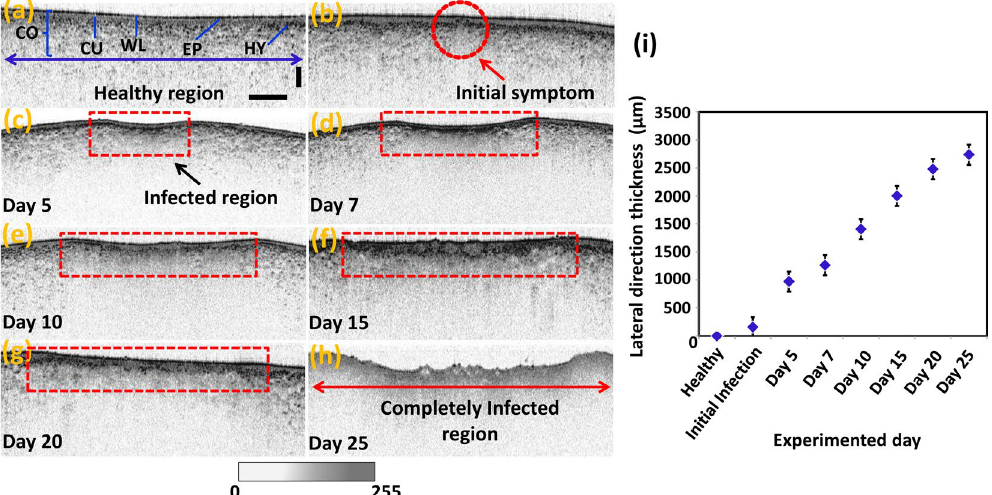
Figure 4. Morphological changes as a function of the incubation of bitter rot disease ( a–h ). Graph ( i ) depicts the gradual thickness expansion of the infected region in the lateral direction. Abbreviations: CO, cortex; CU, cuticle; EP, epidermis layer; HY, hypodermis layer; WL, wax layer. Vertical and horizontal scale bars, 500 μ